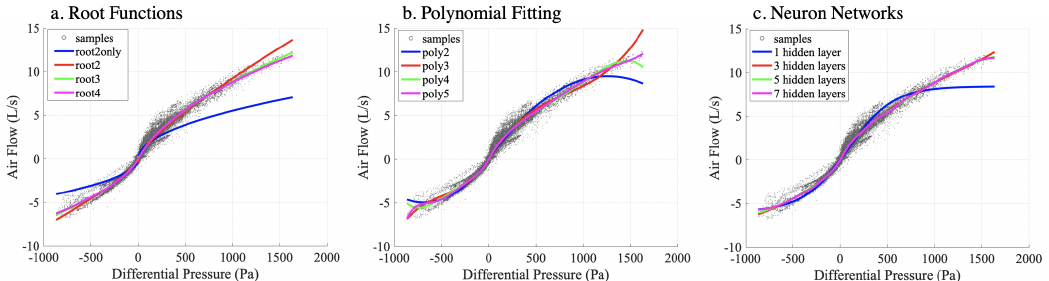
Figure 12. Linear fitting with The root models ( a ), polynomial curves ( b ) and neural network ( c ) regression fitting on The data from all participants combined.